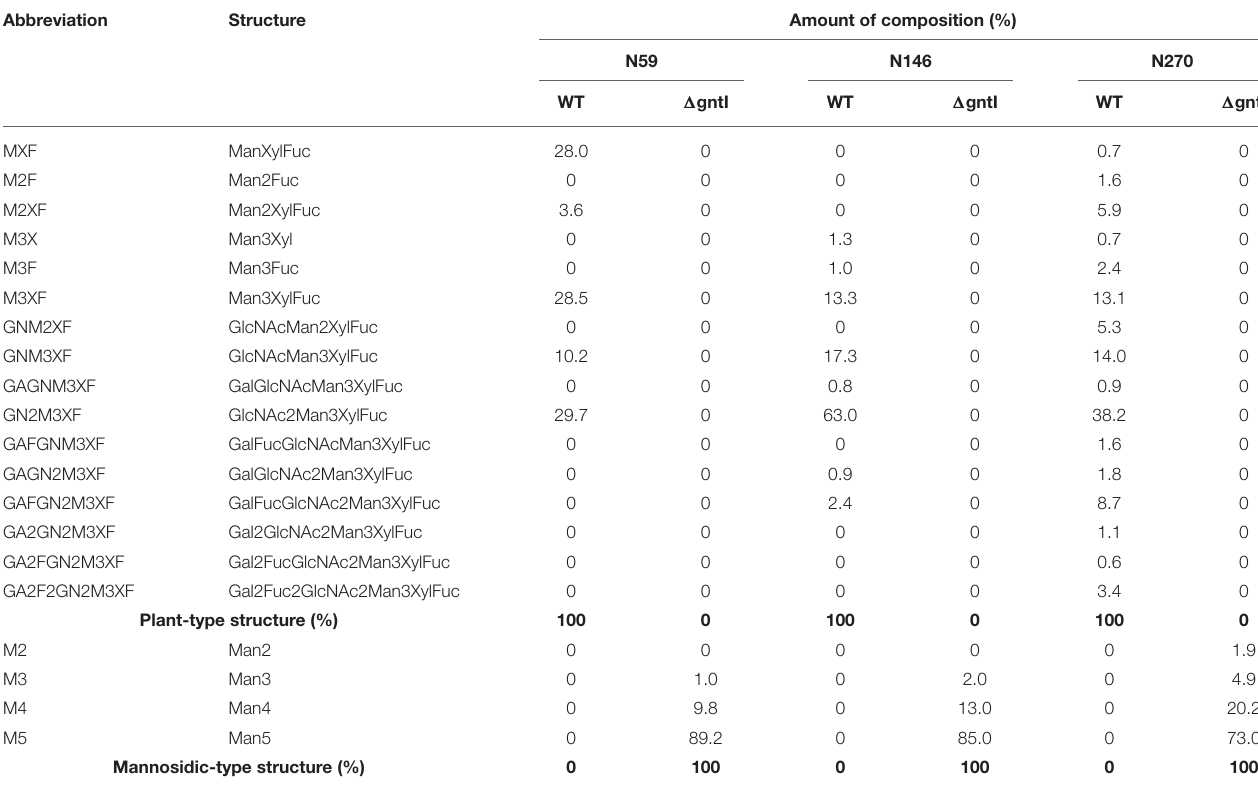
TABLE 1 | Composition of N -glycan structures on purified GCases from wild type and 1 gntI agroinfiltrated plants at three N -glycosylation sites (N59, N146, and N270).